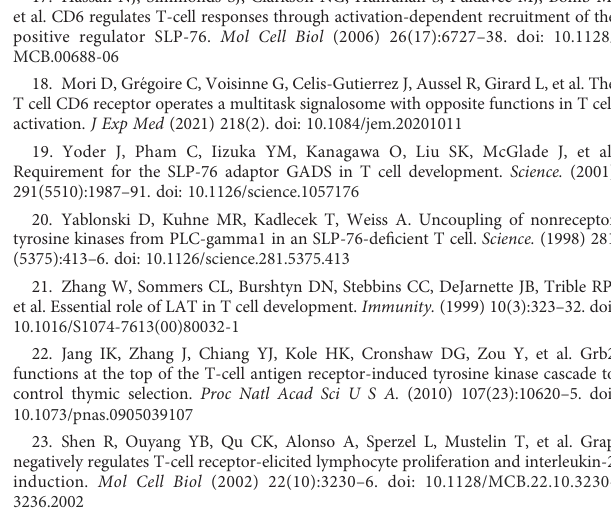
SUPPLEMENTARY FIGURE 1 Schematic showing the inactivation of a GRAP allele following insertion of a ‘ SUPPLEMENTARY FIGURE 2 Proteomes of variant Jurkat T cell lines. Protein copy number comparisons between parental and variant Jurkat T cell lines. WT refers to the SLP76 OST variant while GADS -/- , GRB2 -/- and GRAP -/- refer to the SLP76 OST variants de fi cient for GADS (GRAP2), GRB2 and GRAP respectively. The canonical effectors of the TCR signaling pathways are